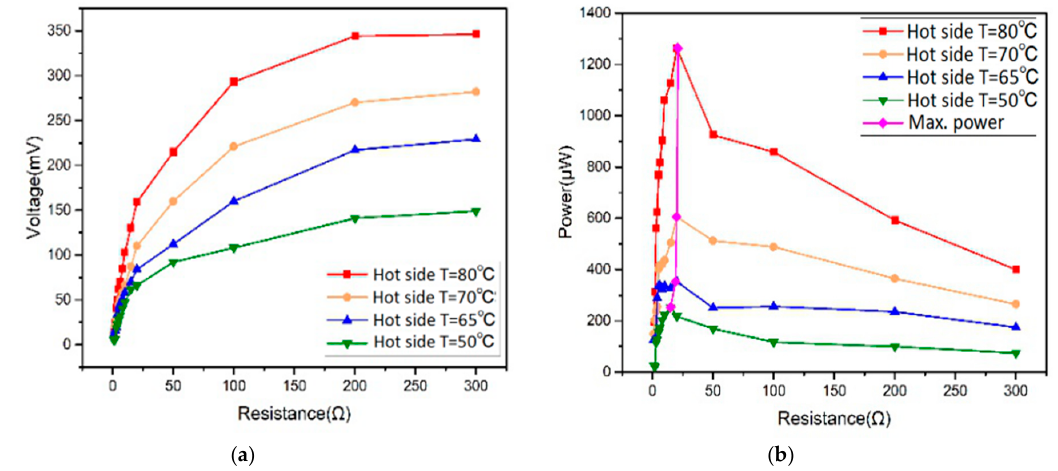
Figure 6. ( a ) Voltage and ( b ) power outputs of TEGs under different load resistances.